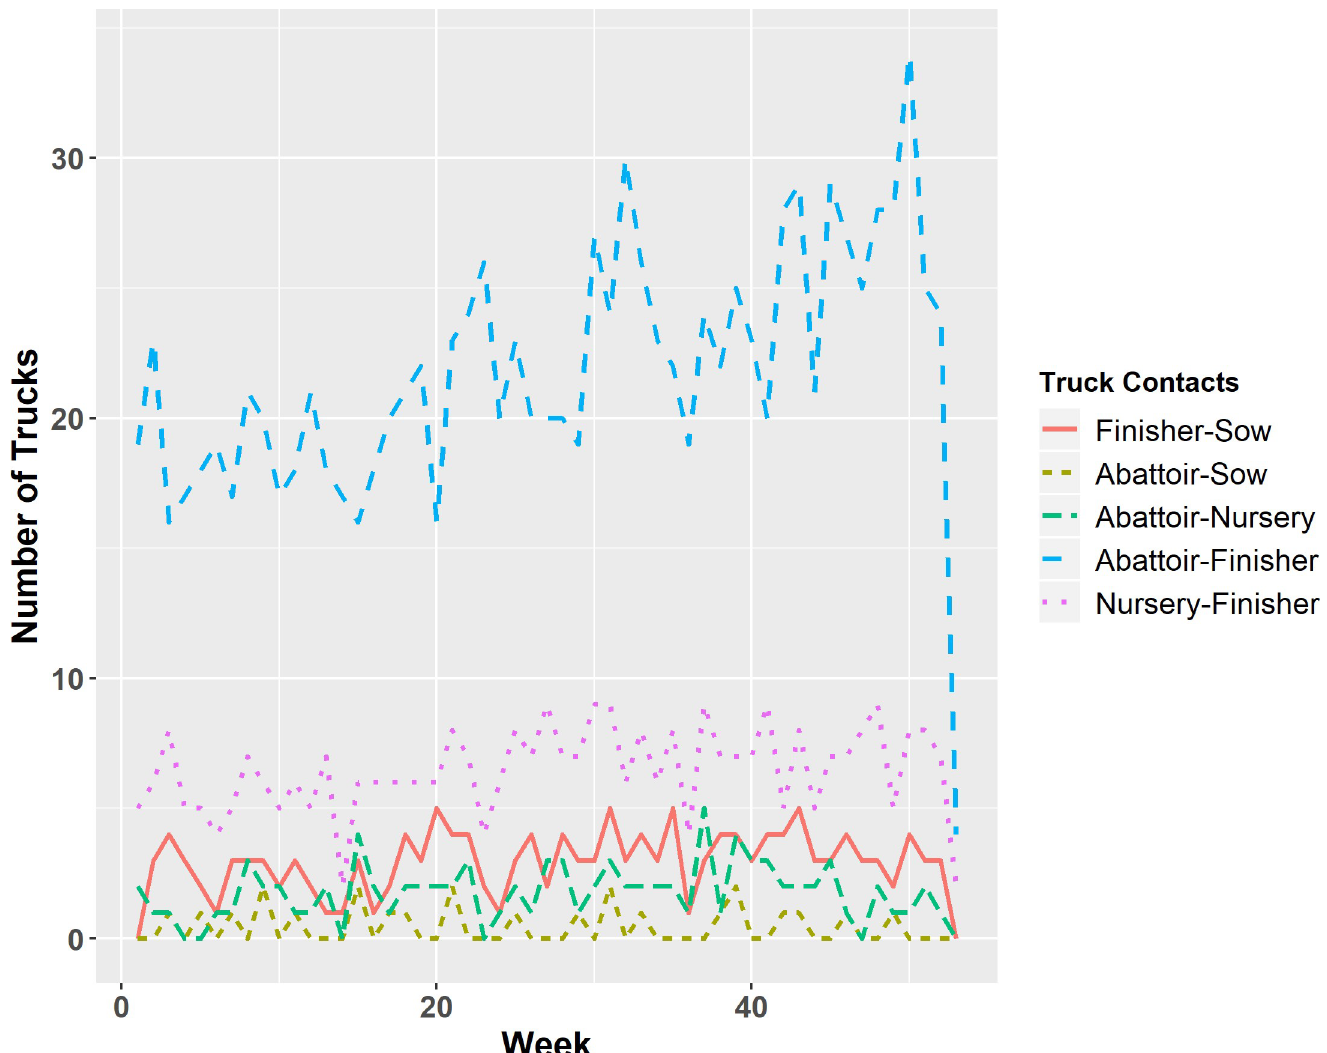
Fig 3. The total number of trucks that had contact with a specific combination of facility types within a given